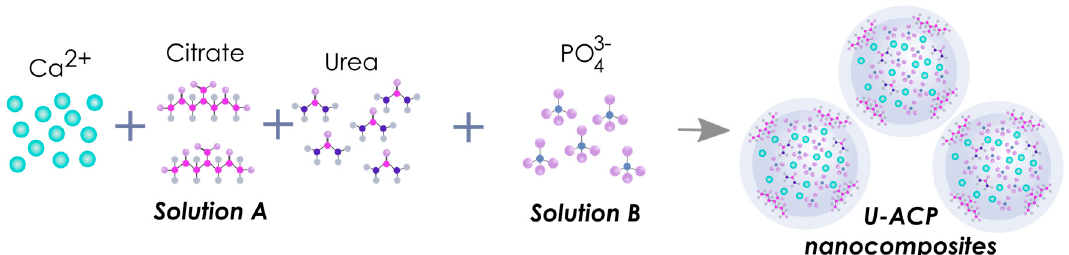
Scheme 1. Graphical sketch of the batch method used to obtain U-ACP nanofertilizers.